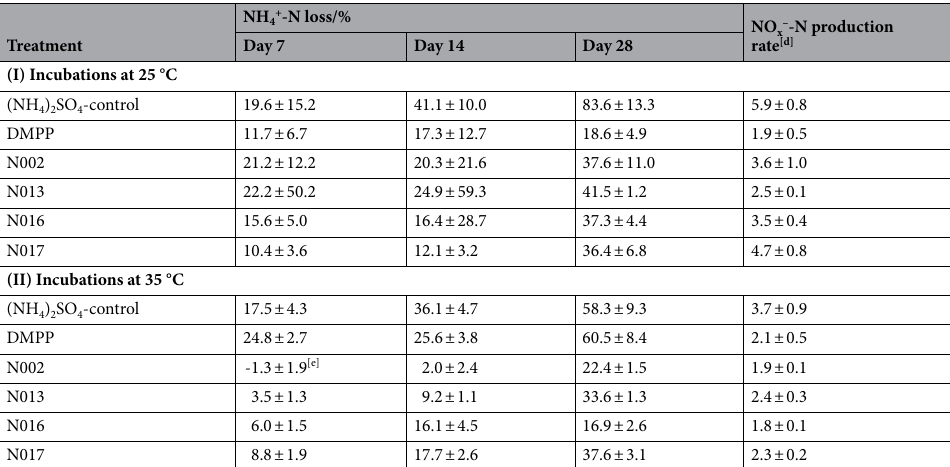
Table 3. Ammonium loss (%) during a 28-day incubation and NO x– -N production rate in Dahlen soil (pH 7.3). All samples were treated with the fertiliser (NH 4 ) 2 SO 4 at a rate of 100 mg N kg -1 .[ a , b , c ]. [ a ] Application rates are 10 mol% of applied fertiliser N. [ b ] Ammonium loss was calculated from NH 4+ -N concentrations detected in samples at each timepoint. [ c ] Mean values (n = 3); errors are standard errors of the mean. [ d ] After 28 days; in mg NO x– -N/kg soil/day. [ e ] Negative value could indicate that treatment may trigger priming effects in the soil (see